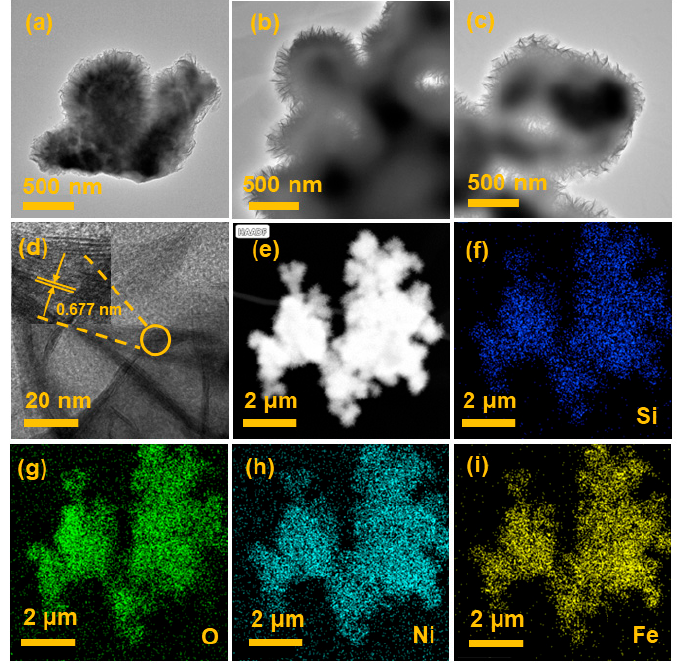
Figure 1. TEM images of ( a ) SiO 2 @NiFe LDH-1, ( b ) SiO 2 @NiFe LDH-2, ( c , d ) SiO 2 @NiFe LDH-3, and ( e – i ) HAADF results for SiO 2 @NiFe LDH-3. The XRD spectra of Figure S4 confirm the composition of pure SiO 2 . Wide peaks in the XRD spectrum of SiO 2 indicate that it is an amorphous phase. Due to its inherent hy- drophilicity, SiO 2 microspheres are conducive to the adsorption of Fe 3+ and Ni 2+ ions, pro- mote the uniform coverage of Fe 3+ and Ni 2+ on the surface of SiO 2 microspheres, and grow in situ to form NiFe LDH nanosheets. In the XRD pattern (Figure 2a), the four diffraction peaks located at 2 θ of 11.3°, 22.5°, 34.5°, and 59.7° correspond to (003), (006), (012) and (110) crystal planes, respectively, which are the characteristic diffraction peaks of LDH [30], further illustrating the successful in situ growth of a typical hydrotalcite-like material on the surface of SiO 2 , wherein (003) the crystal plane spacing is 0.68 nm.